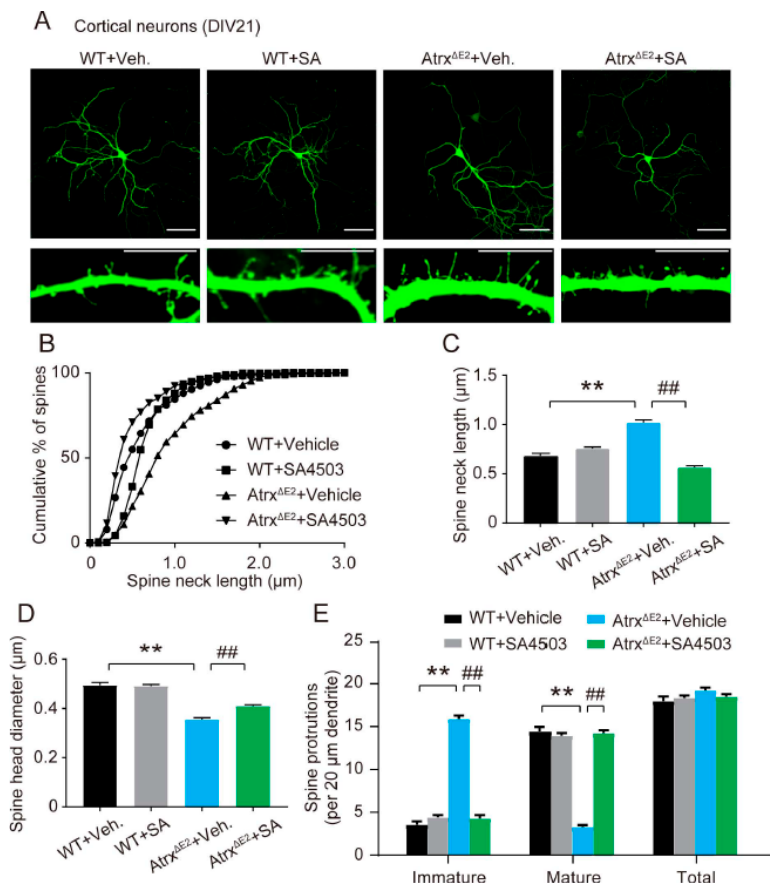
Figure 2. Treatment with SA4503 ameliorates dendritic spine abnormality in cultured Atrx Δ E2 neuron. ( A ) Representative images of EGFP-transfected cortical neurons at DIV21. Neurons are stained for anti-GFP. Images in the bottom panels are enlarged from each dendrite. Scale bars: top panels, 100 µm; bottom panels, 10 µm. ( B ) Relationship between cumulative percentage of spines and spine length. p < 0.01 in WT versus Atrx Δ E2 neurons and in Atrx Δ E2 versus SA4503-treated Atrx Δ E2 neurons by the Kolmogorov–Smirnov test. ( C ) Data show the number of spines. ** p < 0.01 versus vehicle-treated WT neurons; ## p < 0.01, versus vehicle-treated Atrx Δ E2 neurons by one-way ANOVA with post hoc Tukey’s test; F (3, 1494) = 89.38. ( D ) Data show the spine-head diameter. ** p < 0.01 versus vehicle-treated WT neurons; ## p < 0.01, versus vehicle-treated Atrx Δ E2 neurons by one-way ANOVA with post hoc Tukey’s test; F (3, 76) = 76.38. ( E ) Spine protrusions per 20 µm dendritic length. ** p < 0.01 versus vehicle-treated WT neurons; ## p < 0.01, versus vehicle-treated Atrx Δ E2 neurons by two-way ANOVA with post hoc Bonferroni's test; F (3, 228) = 2.549, p = 0.0566 (group); F (2, 228) = 1008, p < 0.01 (spine protrusions), F (6, 228) = 243.6, p < 0.01 (interaction between group and spine protrusions); n = 20 neurons for each group. The experiments were repeated three times with similar results. WT, n = 360 spines; SA4503-treated WT, n = 367 spines; Atrx Δ E2 , n = 384 spines; SA4503-treated Atrx Δ E2 , n = 370 spines. Each bar represents the mean ± SEM. Abbreviations: Veh., vehicle; SA, SA4503.